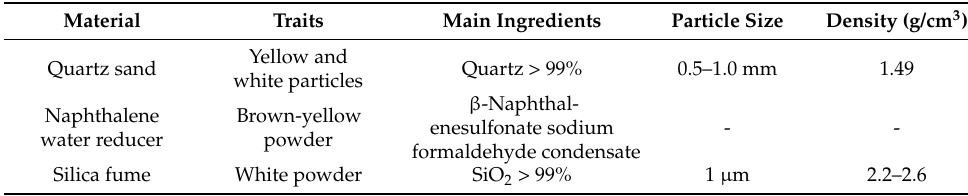
Table 2. Detailed parameters of aggregate and